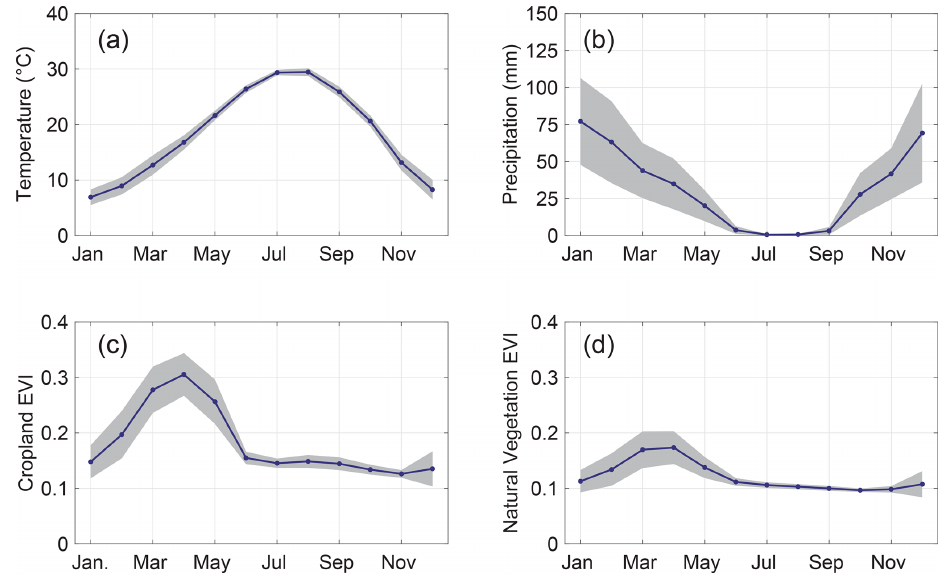
Figure 2. Monthly variations of climatic factors and vegetation in Syria. (a–b) Precipitation (mm) and temperature ( ◦ ). (c–d) EVIs of natural vegetation and croplands. All the data are the averages during